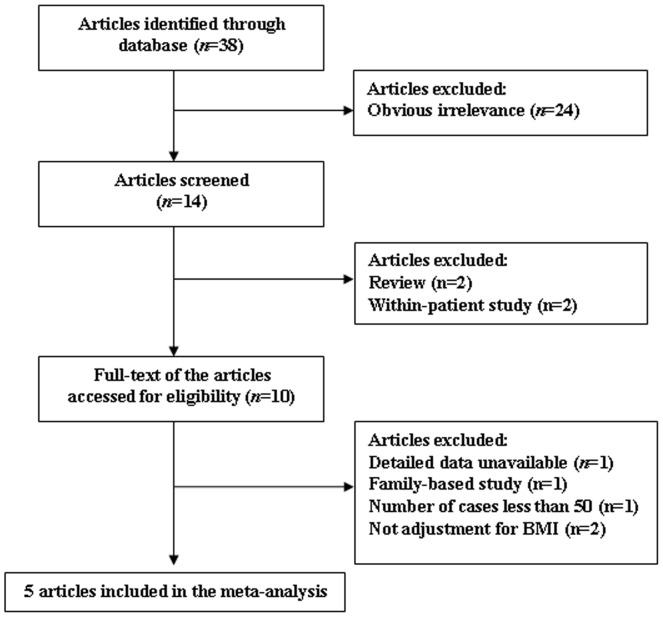
Flow chart of article selection for meta-analysis.